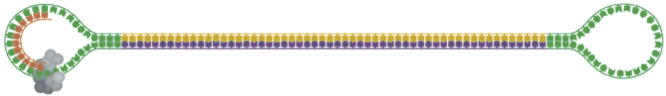
SMRTbell templateHairpin adaptors (green) are ligated to the end of a double-stranded DNA molecule (yellow and purple), forming a closed circle. The polymerase (gray) is anchored to the bottom of a ZMW and incorporates bases into the read strand (orange). The image is adapted from [2] with permission from the Oxford University Press.